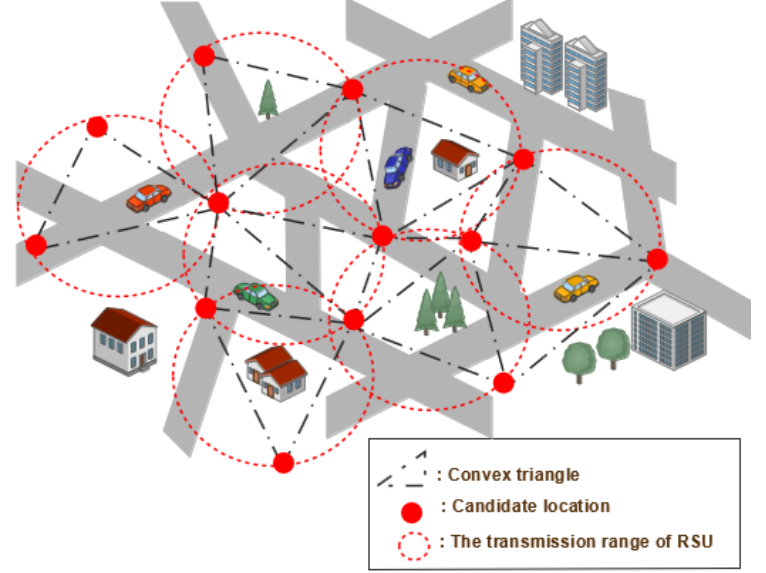
Figure 4. Constrained Delaunay triangulation